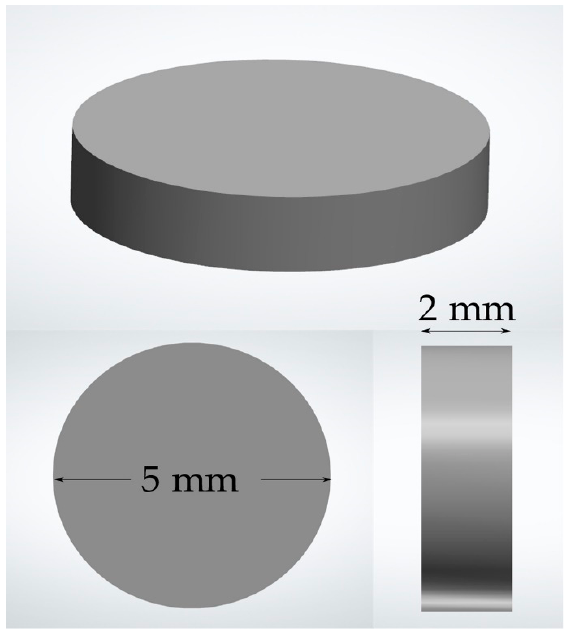
Figure 2. Dimensions of specimens used in the study. Table 2. Polishing protocol used in the study.